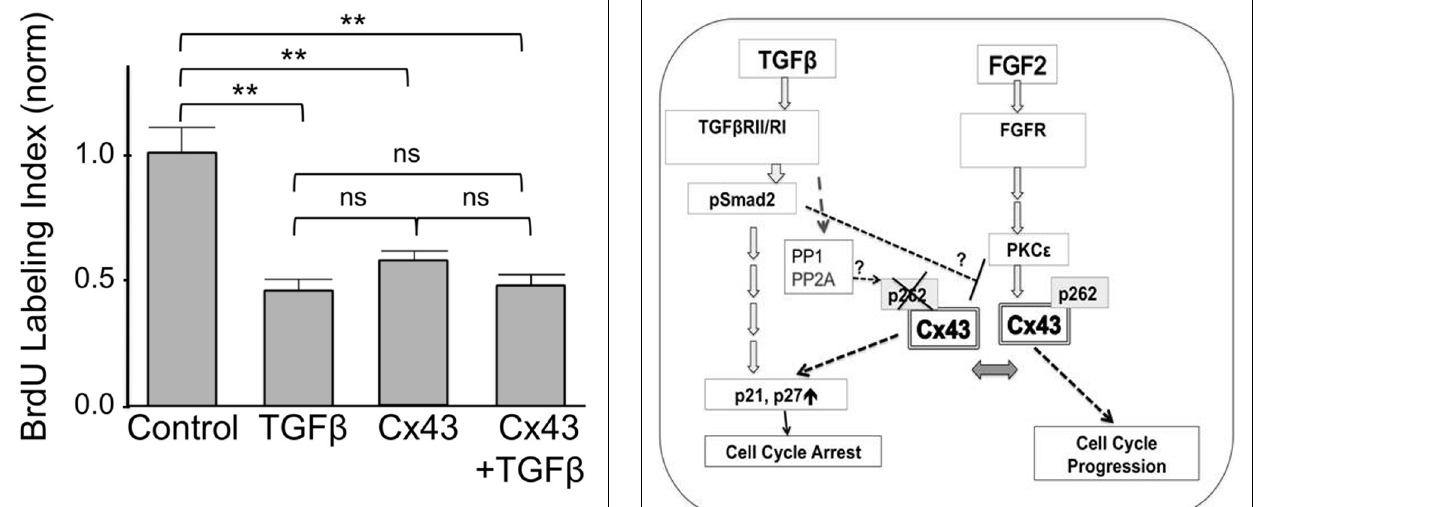
FIGURE 5 | Suppression of DNA synthesis by Cx43 overexpression is not additive to that byTGF β . The y -axis shows normalized BrdU labeling index of untreated cardiomyocytes (Control); cardiomyocytes treated with TGF β ; subjected to Cx43 overexpression; or treated withTGF β in the presence of Cx43 overexpression, as indicated. Absolute BrdU labeling index was at 0.3. Data are shown as mean ± SEM. Brackets show comparisons between groups. ** and ns correspond to P < 0.01, or P > 0.05.